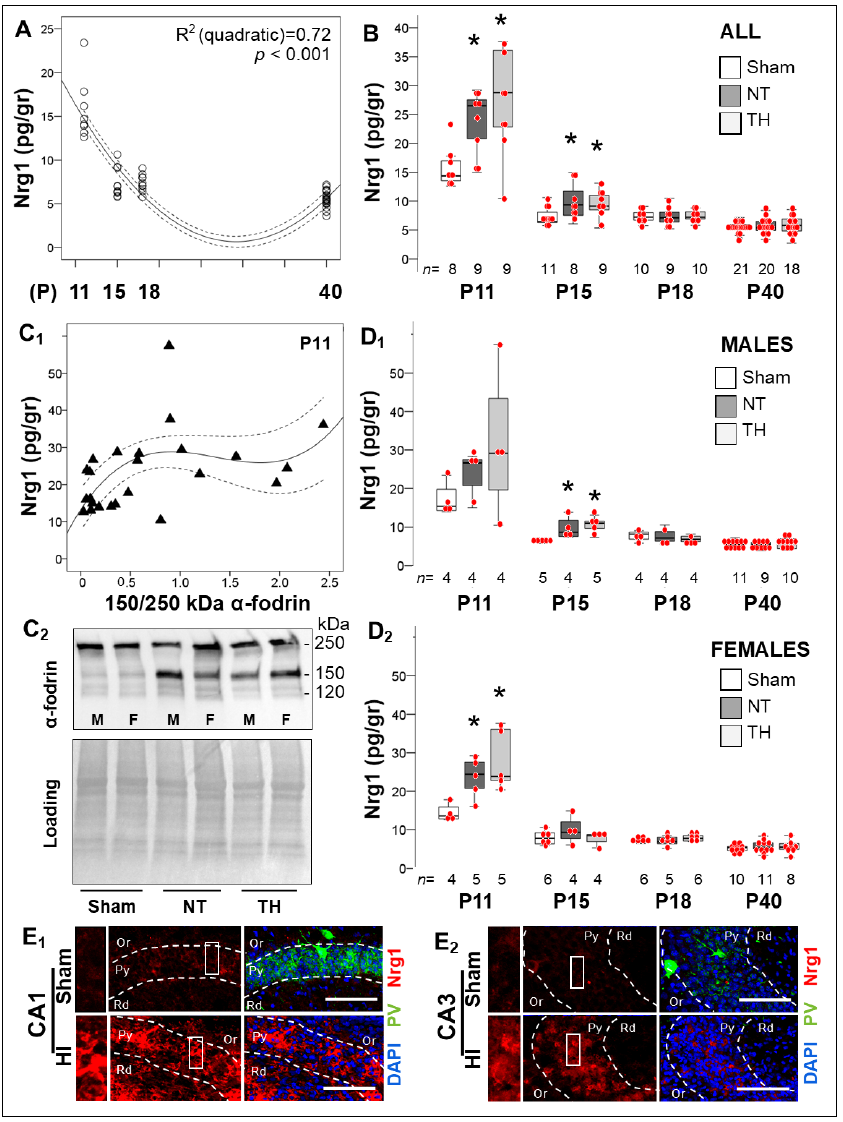
Figure 5. Long-term changes in Nrg1 levels in the hippocampus in response to neonatal HI. ( A ) Hippocampal Nrg1 levels decreased between P11 and P18 and reach a nadir prior to P40 (quadratic R 2 0.72, p < 0.001). ( B ) HI increased hippocampal Nrg1 levels by 84.4% ( p = 0.01) and 44.8% ( p = 0.05) at P11 and P15 after the insult, respectively (KW p <0.05; *, Dunn-Bonferroni post-hoc p < 0.05 vs. sham). After 120h, Nrg1 was similar in all three groups. ( C ) The 150 kDa α - fodrin breakdown product weakly correlated with Nrg1 (Spearman’s Rho r = 0.53, p = 0.004) in a cubic regression, which plateaued at a Nrg1 level of ~28.5 pg/gr of protein ( C 1 ). Representative western blots demonstrating the breakdown of α - fodrin are shown at 120 and 150 kDa ( C 2 ). ( D ) Stratification by sex, demonstrated that Nrg1 peaked early after neonatal HI in both male and female mice (KW p = 0.02 and KW p = 0.01, respectively), but sooner in female mice. ( E ) Higher Nrg1 (red) and lower PV (green) expression are shown in CA1 ( E 1 ) and CA3 ( E 2 ) pyramidal cell layer (Py) in the dorsal hippocampus of HI-injured mice compared to sham by IF-IHC and confocal microscopy. Scale bar = 200 µm. Quantifications are shown as hybrid box & whisker and vertical dot plots. *, p <0.05 (Dunn-Bonferroni post-hoc test for Kruskal Wallis ANOVA; n shown under each box).